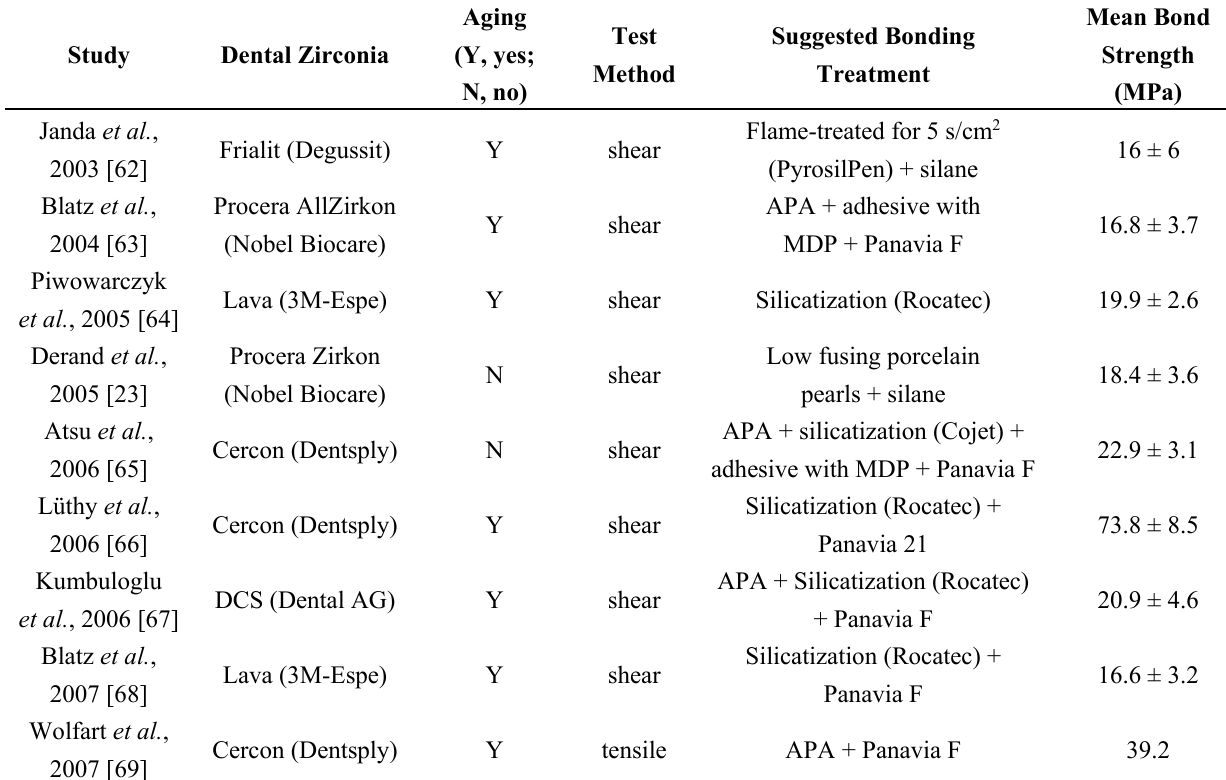
Table 1. Experimental studies, in chronological order, on resin bonded dental